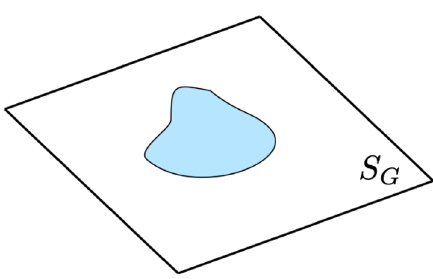
Figure 3 . A schematic diagram of Herm ( H ) , which contains the subspace S G of Hamiltonians invariant under G . The subspace contains the Hamiltonian ensemble E H , represented by a light blue